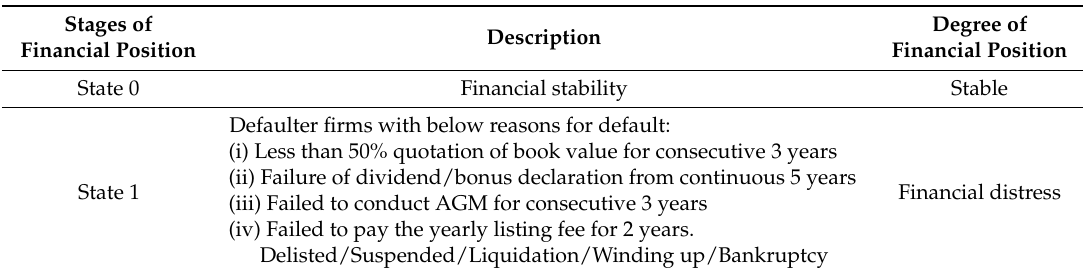
Table 1. Definition of financial distress